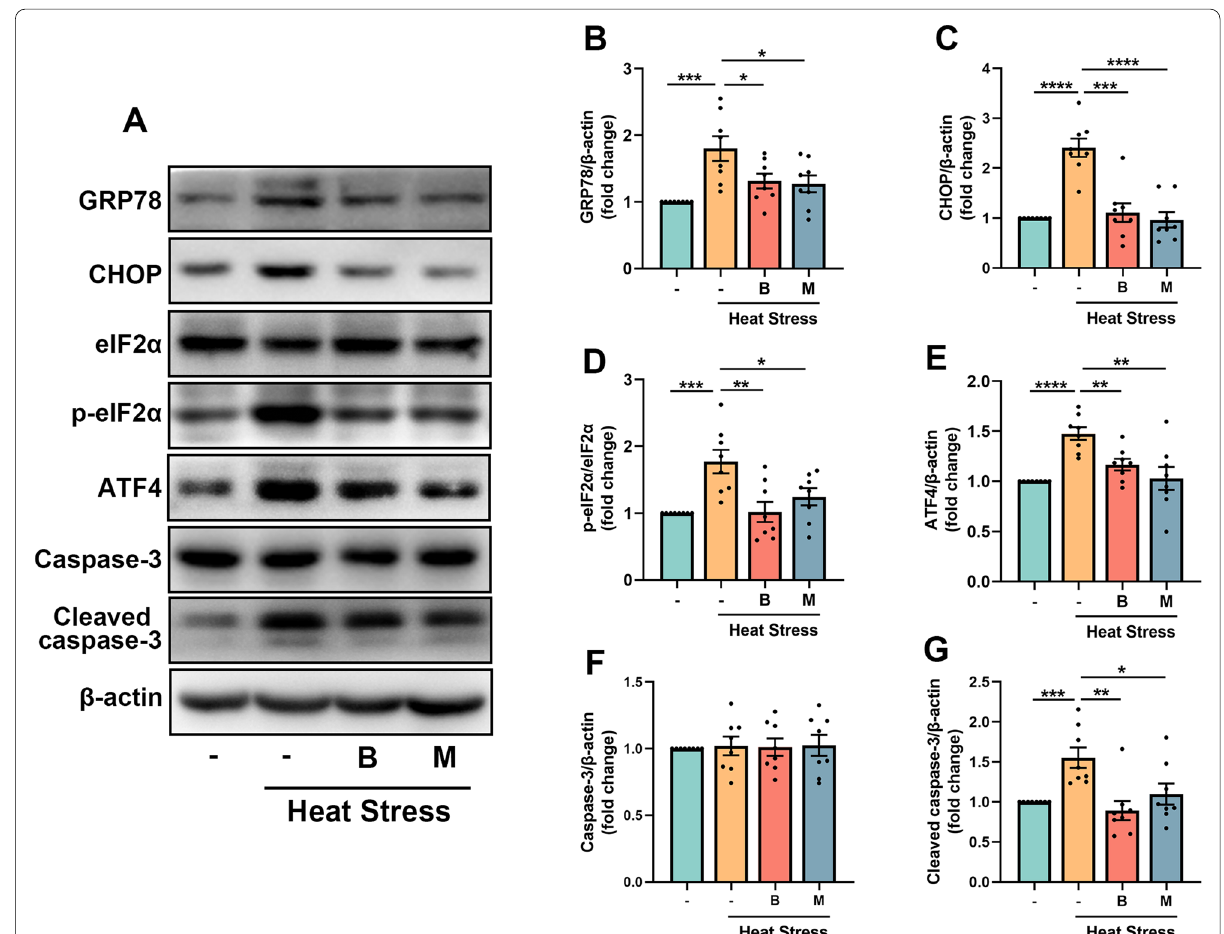
Fig. 6 BHBA inhibits ER stress and cell apoptosis induced by heat stress. A Western blots of GRP78, CHOP, eIF2α, p-eIF2α, ATF4, caspase-3, cleaved caspase-3 and β-actin. B - G Relative expressions of GRP78 ( B ), CHOP ( C ), p-eIF2α/eIF2α ( D ), ATF4 ( E ), caspase-3 ( F ) and cleaved caspase-3 ( G ). Except for caspase-3, all above proteins increased significantly in the heat stress-treated mouse hippocampus and these elevated protein levels in the heat stress-treated mice were restored by BHBA or minocycline treatment. Data were normalized to β-actin: expression of the target protein of target protein band/intensity of β-actin. The results are presented as the ratio of the experimental group to the control group with the value taken as 1. All data analyses were performed using one-way ANOVA with Tukey’s post-test. Data are represented as mean * p < 0.05, ** p < 0.01, *** p < 0.001, **** p < 0.0001. ATF4, activating transcription factor 4; B, BHBA; CHOP, C/EBP homologous protein; eIF2α, eukaryotic initiation factor 2α; GRP78, glucose-regulated protein 78; M, minocycline; p-eIF2α,